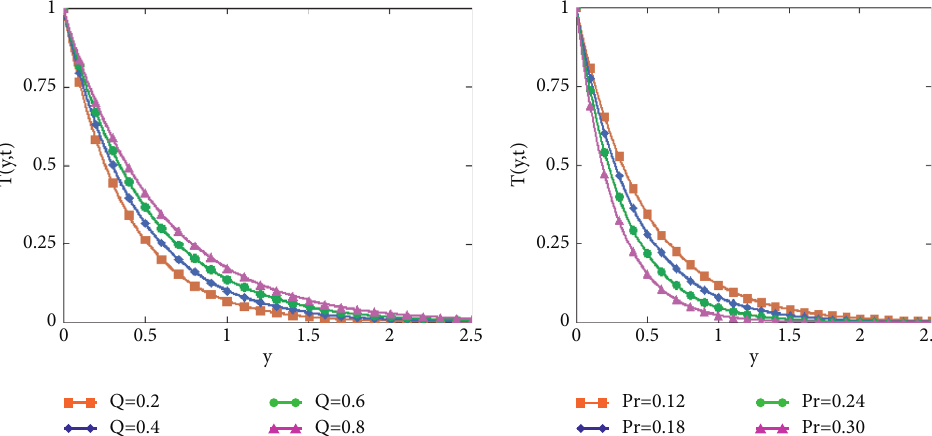
Figure 7: Variation in temperature profile T ( y, t ) for various values of heat generation parameter Q and Pr at c � 0 . 5.